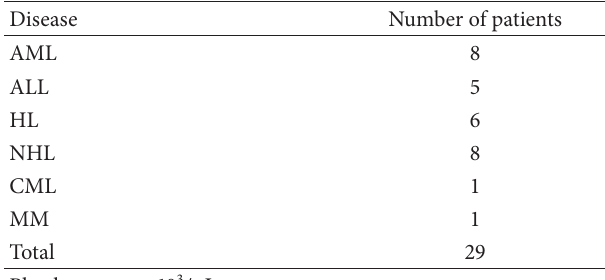
Table 1: Patient characteristics. Table 2: Results of the McNemar test and absolute number of different complications in the pre- and the